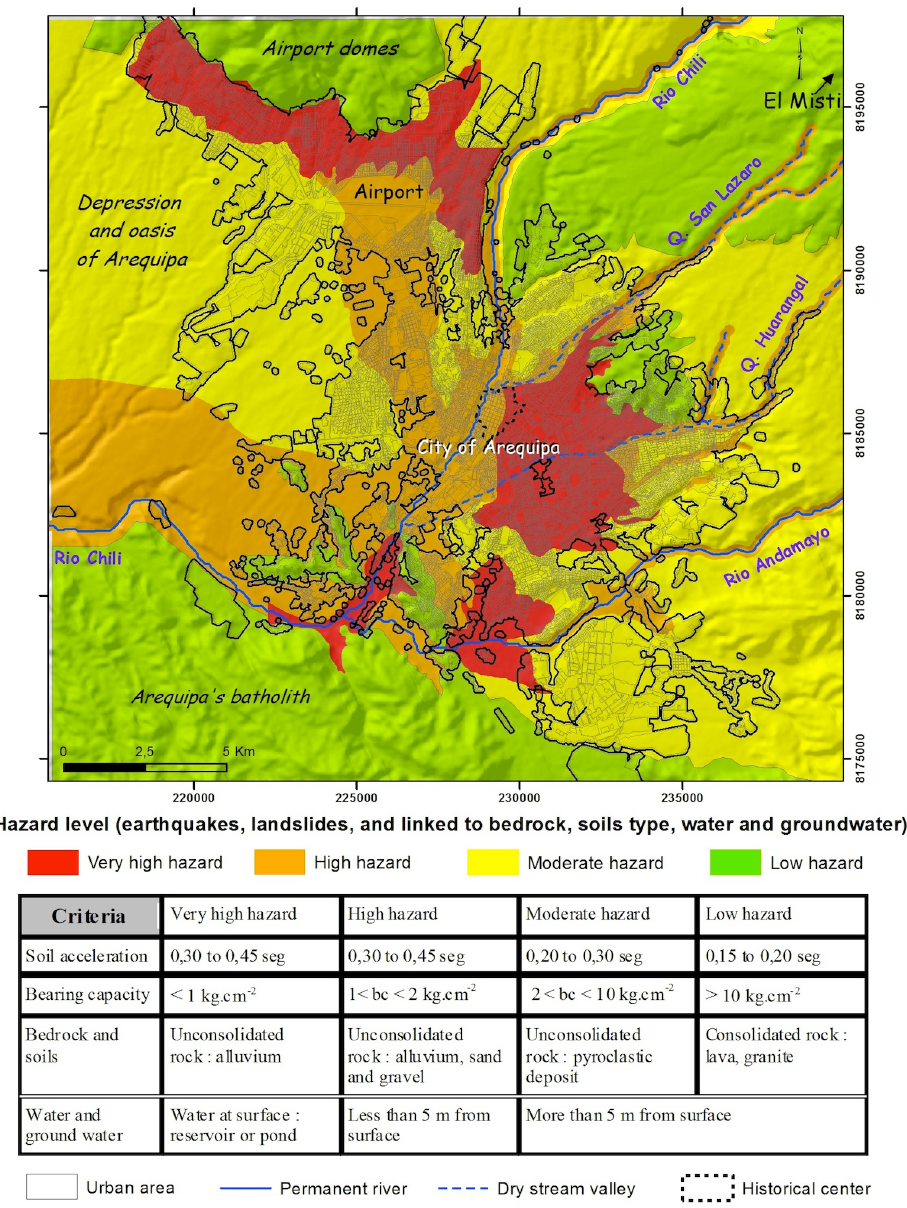
Fig. 2. Multi-hazard-zone map of the city of Arequipa showing hazard level (low to very high) for earthquake and landslide, and that related to bedrock, soil type, water and